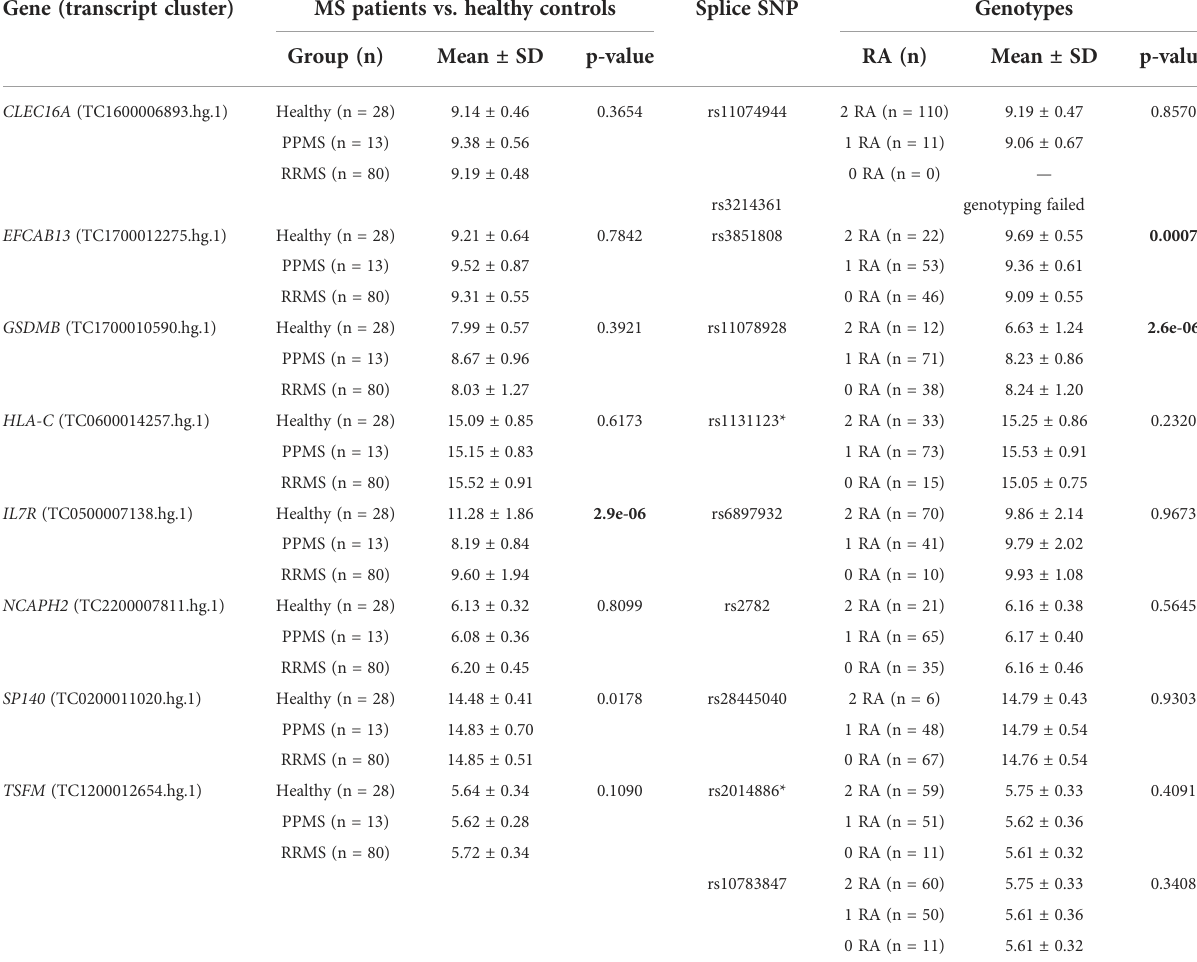
TABLE 3 Differential gene expression in the B-cell transcriptome data set. Gene (transcript